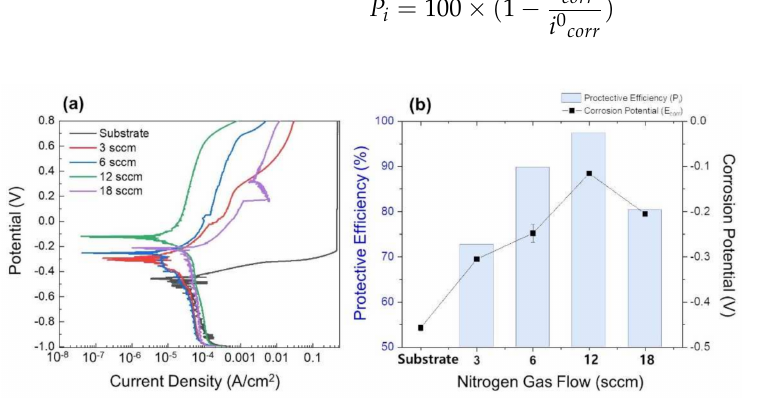
Figure 7. ( a ) Potentiodynamic polarization curves and ( b ) corrosion potential and protective efficiency.